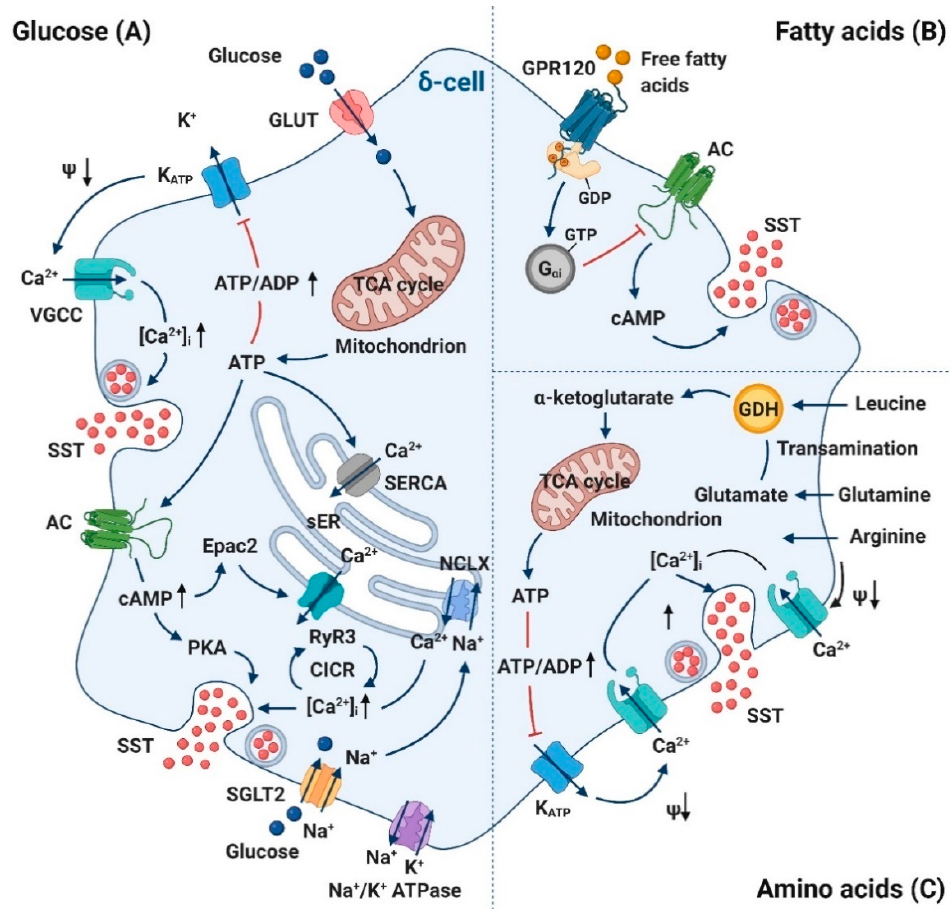
Figure 2. Nutrient-secretion coupling in δ -cells. ( A ) Glucose stimulates δ -cell somatostatin secretion via both membrane potential-dependent (“V m -dependent”) and -independent pathways (“V m -independent”). V m -dependent pathway: Glucose metabolism increases cytoplasmic ATP/ADP ratio and consequently closes K ATP channels. The subsequent membrane depolarization leads to opening of voltage-gated Ca 2+ channels (VGCC) and influx of [Ca 2+ ] I to trigger exocytosis. V m -independent pathway: ATP production stimulated by glucose metabolism restores luminal ER calcium levels through SERCA pump and elevates intracellular cAMP via adenylyl cyclase (AC). Whereas cAMP as a second messenger of PKA directly potentiates δ -cell exocytosis, its effect on activation of ryanodine receptor 3 (RyR3) and sensitization of calcium-induced calcium release (CICR) in sER is mediated by Epac2. Glucose also promotes somatostatin secretion by increasing [Na + ] i via sodium-dependent glucose cotransporter 2 (SGLT2) and thereby increases [Ca 2+ ] i through stimulation of intracellular Na + -Ca 2+ exchange (NCLX). The resultant elevation in [Ca 2+ ] i triggers somatostatin secretion. ( B ) Free fatty acids inhibit somatostatin release by binding to non-esterified fatty acids (NEFA)-responsive G-protein coupled receptor 120 (GPR120) on δ -cells. Its downstream G α i inhibits AC activity and decreases cAMP production, which in turn results in reduced activity of PKA. ( C ) The regulatory role of amino acids in δ -cells might resemble their actions in β -cells. We postulate that arginine could stimulate somatostatin secretion via electrogenic transport, thereby increasing membrane depolarization and [Ca 2+ ] i through opening of voltage-gated Ca 2+ channels, while leucine-induced somatostatin secretion might involve transamination of leucine to α -ketoi- socaproate, entry into tricarboxylic acid cycle (TCA) via acetyl-CoA, ATP generation and closure